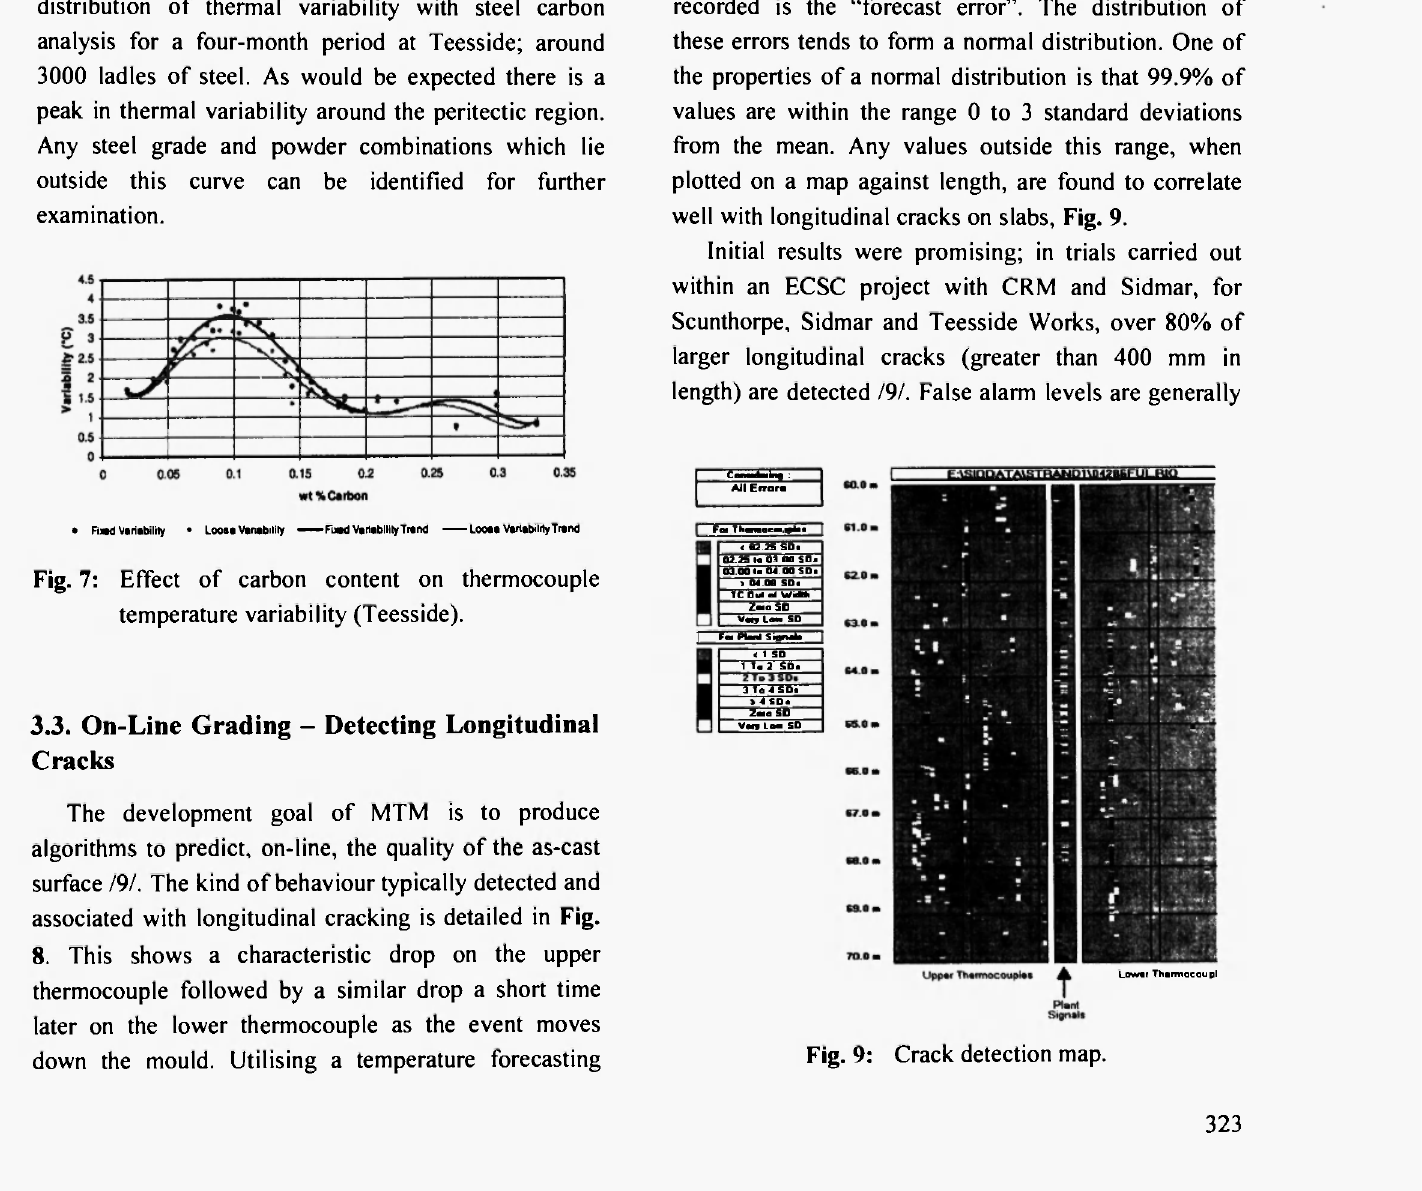
approach, a stochastic auto-regressive algorithm is used to try to predict the next reading from the thermocouple.